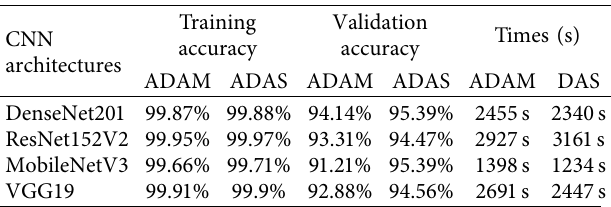
Figure 20: Accuracy of VGG19 network architectures using ADAM and ADAS optimization algorithms. Table 6: Comparison results between network architectures using ADAM and ADAS optimization